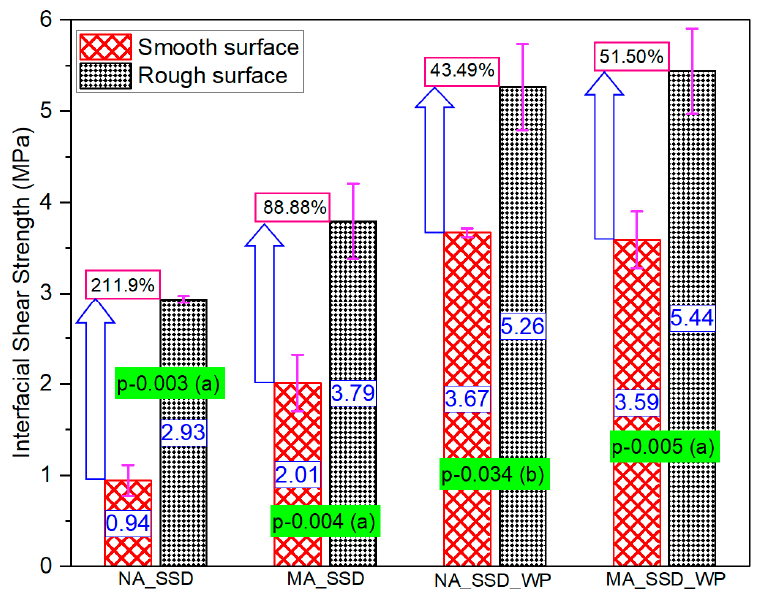
Figure 9. Interfacial shear strength with different surface roughness levels (without-primer cases).